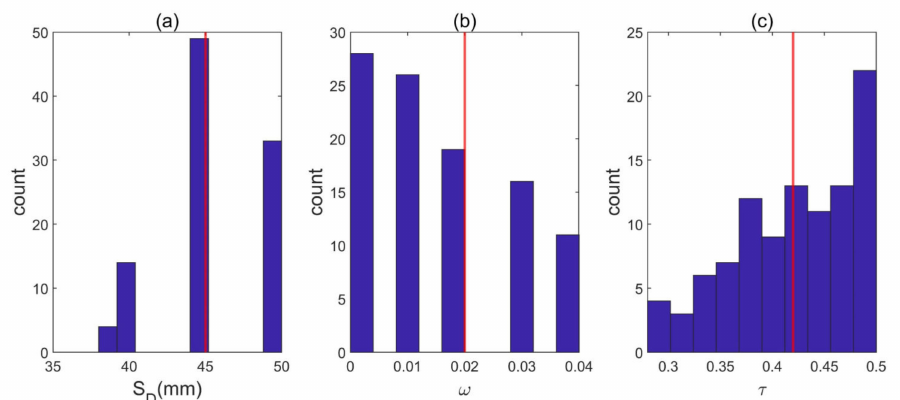
Figure 2. The histogram of ( a ) soil–snow interface roughness S D , ( b ) canopy single scattering albedo ω , and ( c ) transmissivity τ determined by SMOS-observed T B during the snow-free period at station HQ-CM4L in Quebec, Canada. The red vertical lines are the final estimations of τ , ω , and S D .